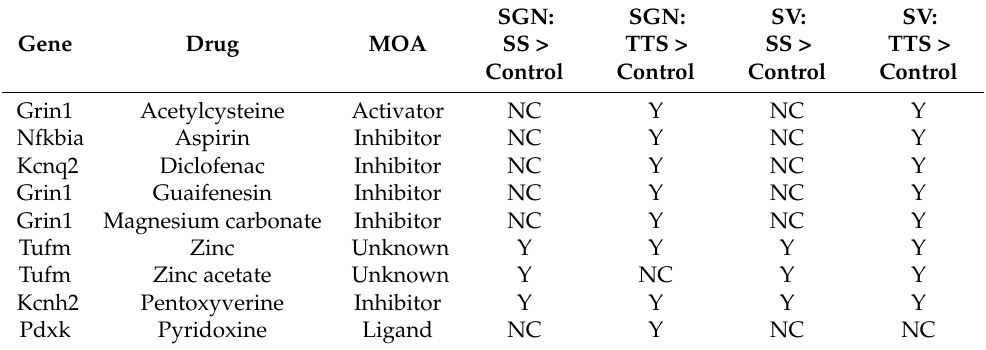
Table 4. FDA approved, orally administered over-the-counter (OTC) drugs that interact with steroid- responsive genes in the cochlea localized to SGN and SV cell types.